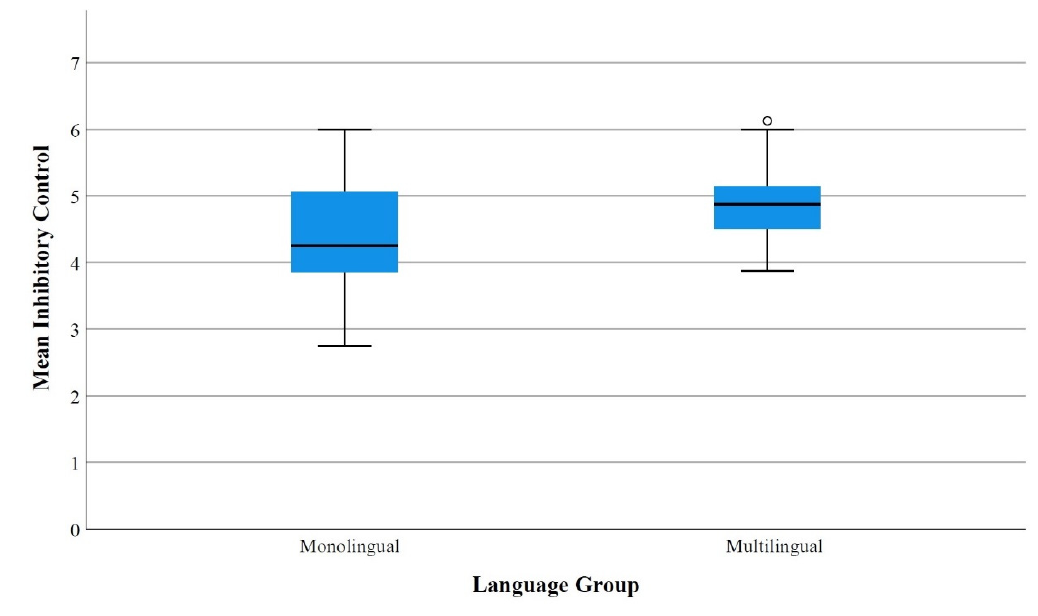
Figure 1. Boxplot of inhibitory control score by language group.